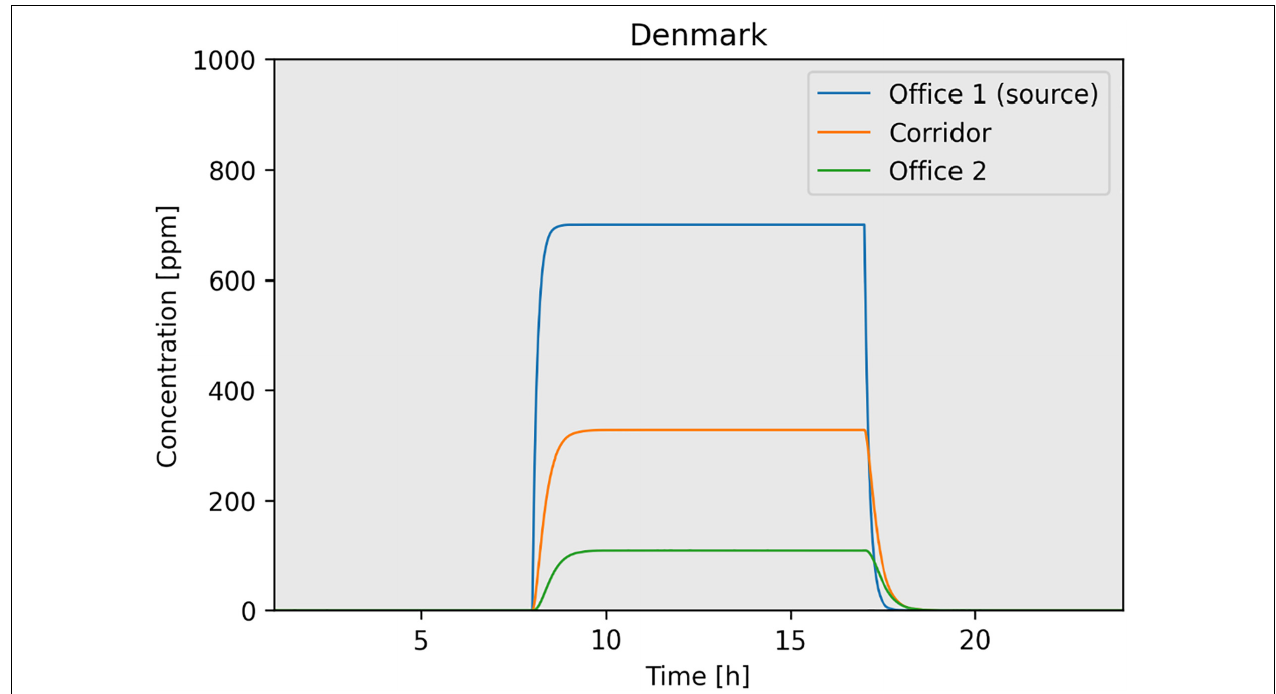
FIGURE 8 | Concentration of contaminants in typical Danish office buildings (background concentration excluded).